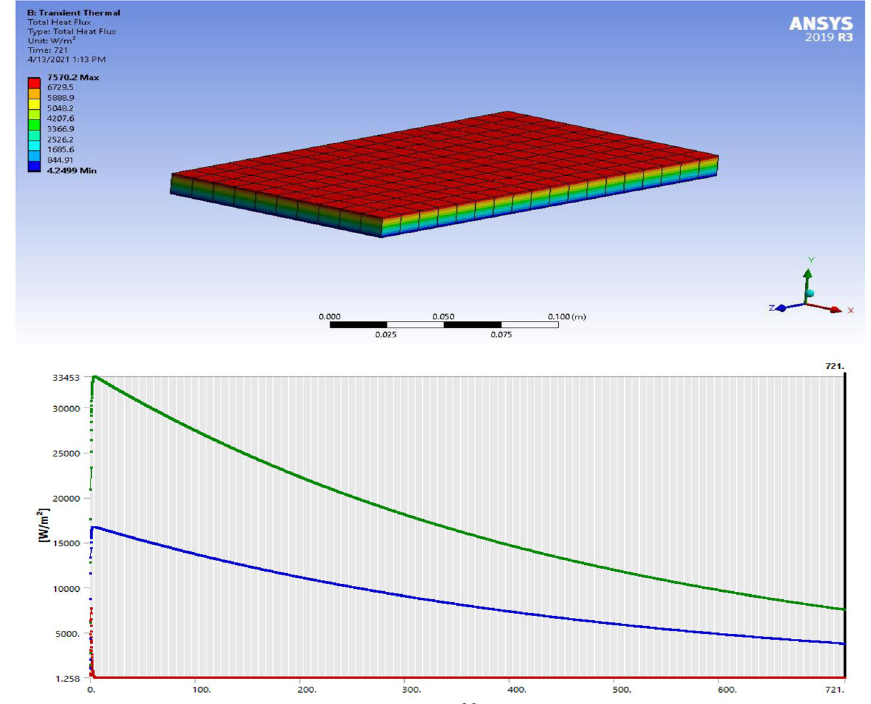
Fig. 13 CFD heat flux model and time plot at 150 °C, D